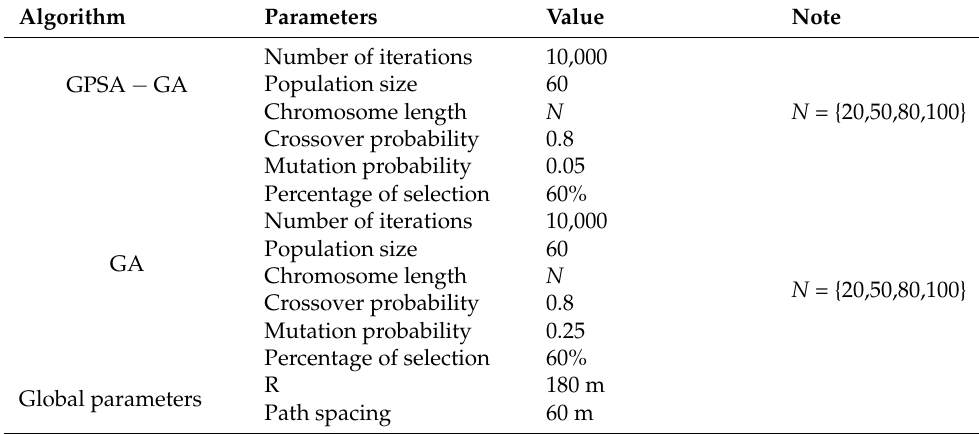
Table 1. List of main parameters of the